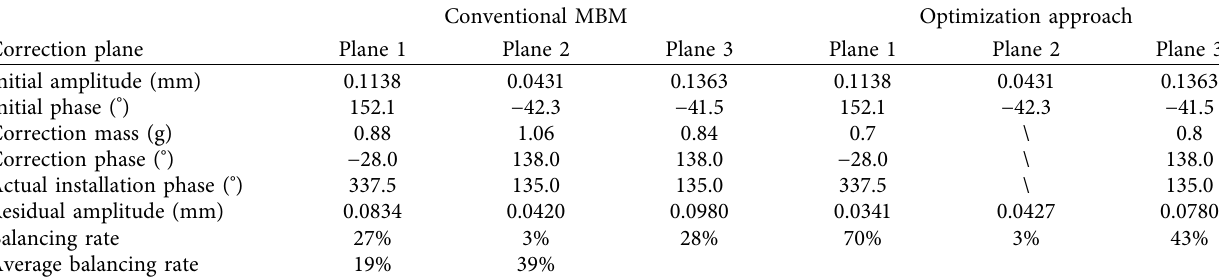
Figure 10: Histogram of the first mode sensitivity matrix. Table 5: Comparison of different methods for the rotor balancing at the second critical